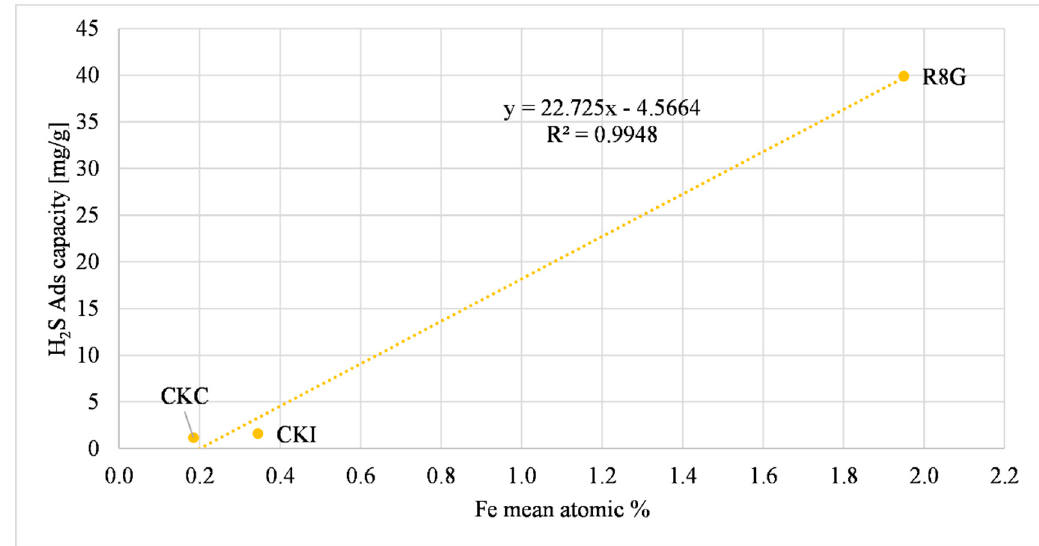
Figure 7. Iron effect on H 2 S adsorption.